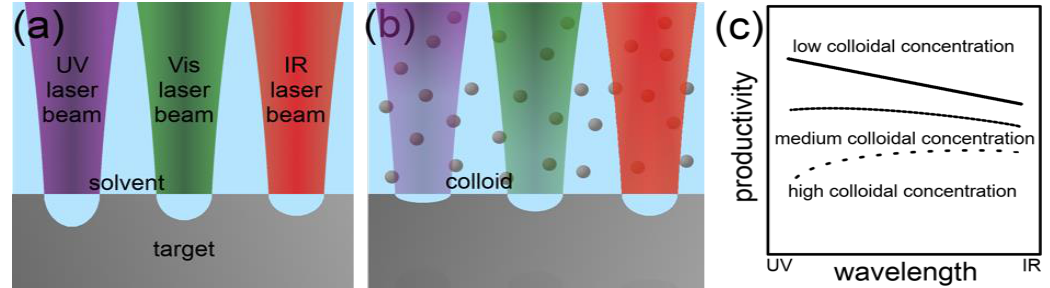
Figure 6. Schematic of the laser ablation of metals in liquids at different wavelengths in absence ( a ) and presence ( b ) of colloidal particles. Equal energy densities were assumed for all laser spots. The diagram in ( c ) (linear scales for both axes) demonstrates the effect of an increasing colloidal concentration on the NP productivity in LAL at different wavelengths. The trends shown in the diagram represent the interpretation of the combined results of the discussed literature in Section 2.2.1. Reprinted with permission from [66].